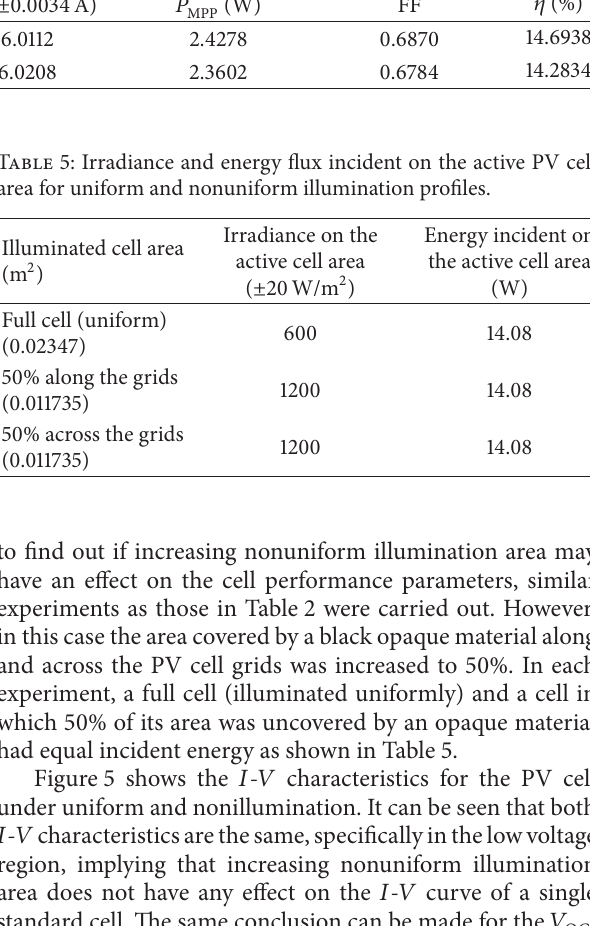
PV cell performance parameters ± 0.0080 V) 𝐼 ± 0.0034 A) 𝑃 𝑉 OC ( SC ( MPP (W) FF